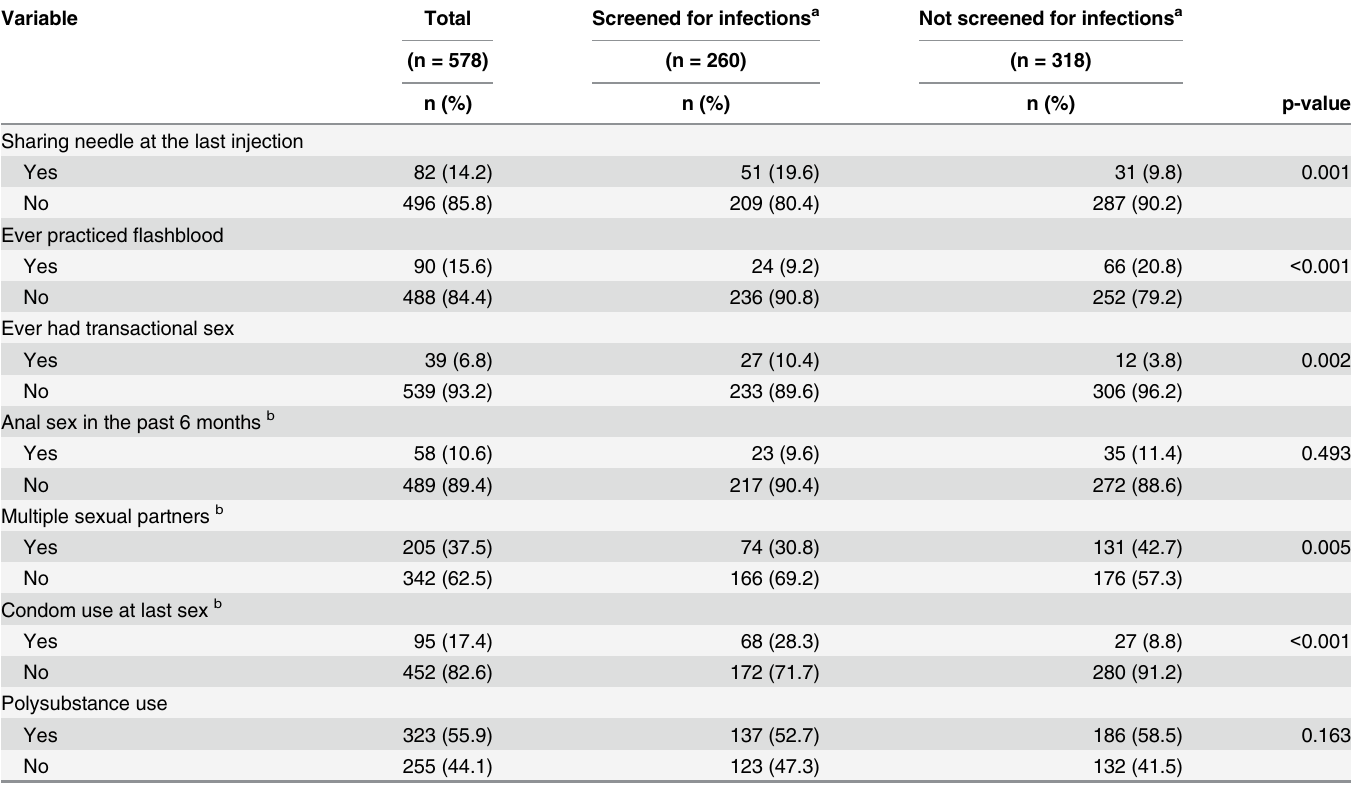
Table 2. Injecting and sexual behaviors of participants.